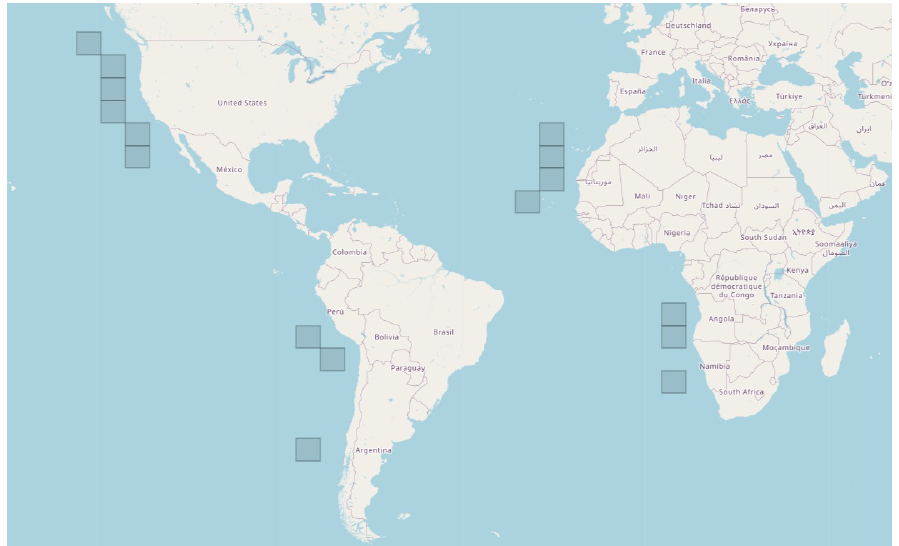
Figure 1. Study areas within each of the Eastern Boundary Currents: California (North Pacific, from 24.17 N to 50.26 N), Canary (North Atlantic, from 13.8 N to 33.76 N), Peru–Chile (South Pacific, from 42.55 S to 13.7 S), and Benguela (South Atlantic, from 29.1 S to 8.32 S). Each tile in the map represents a quasi-quadrangular area of ∼ 6 ◦ side. Specific (latitude, longitude) locations of each quadrangular area can be found on Table